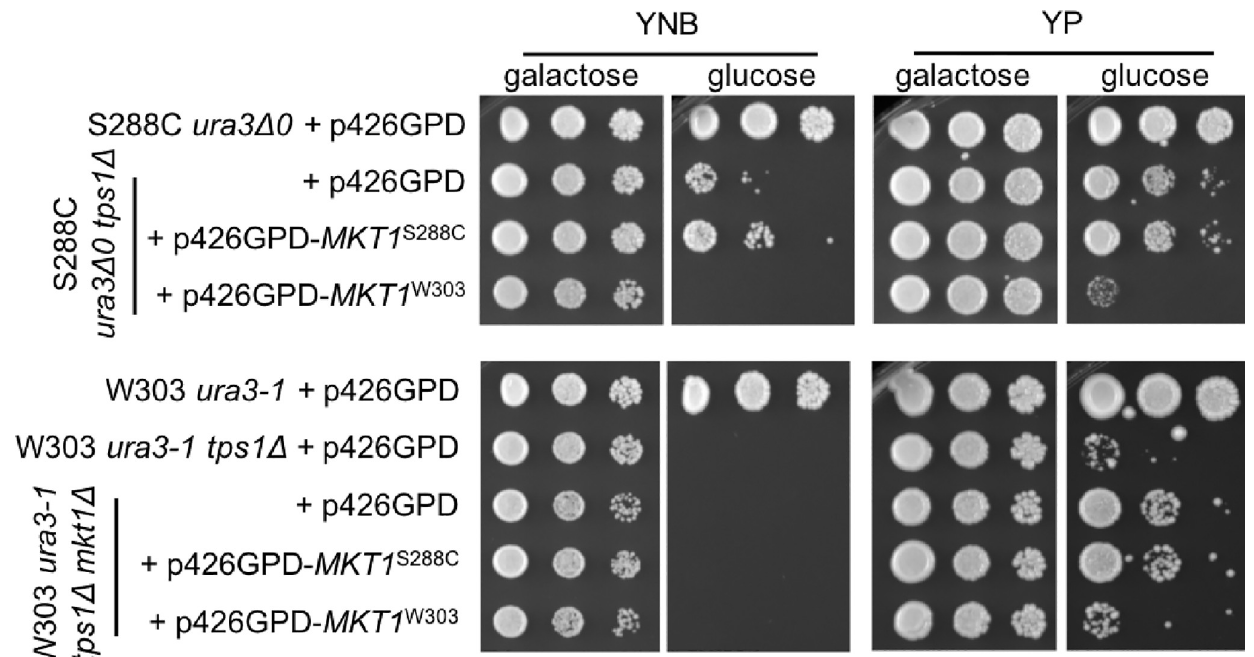
Fig 5. Generation of tps1 Δ persister-like cells is a consequence of MKT1 allelic state. Indicated strains were grown overnight in YNB + 2% galactose liquid before 10-fold serial dilutions were prepared and spotted onto the indicated media. The initial dilution had an OD 600 of 1.0. Listed carbon sources were present at 2%. Plates were incubated at 30˚C for 3 days. Strains used in this figure: DBY12045, DBY12433, DBY15039, PGY185,